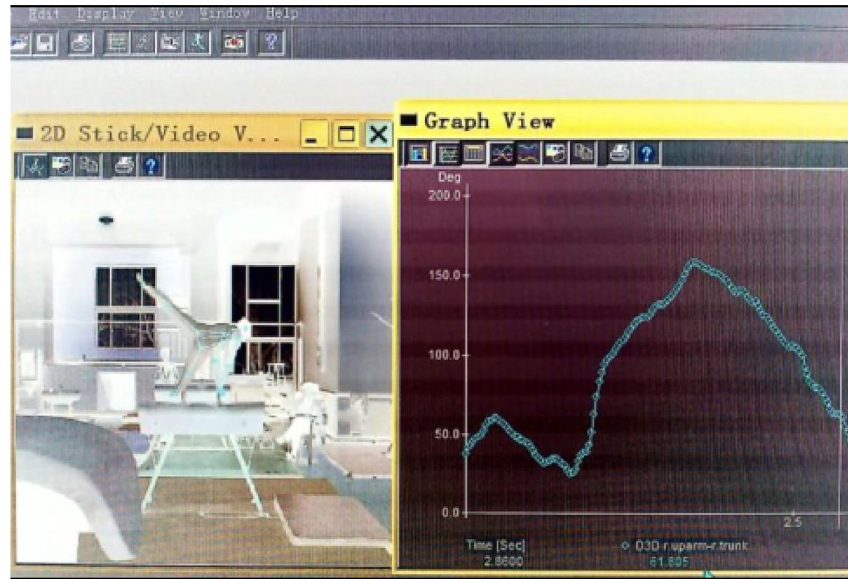
Fig. 9 Screenshot of the cross- handstand athletes reaching the horizontal